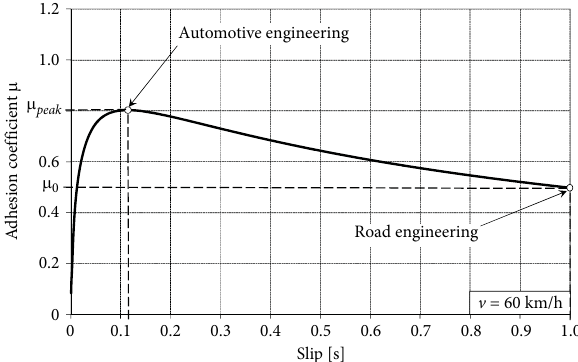
Figure 6. Values of m 0 and m peak based on m ( s )